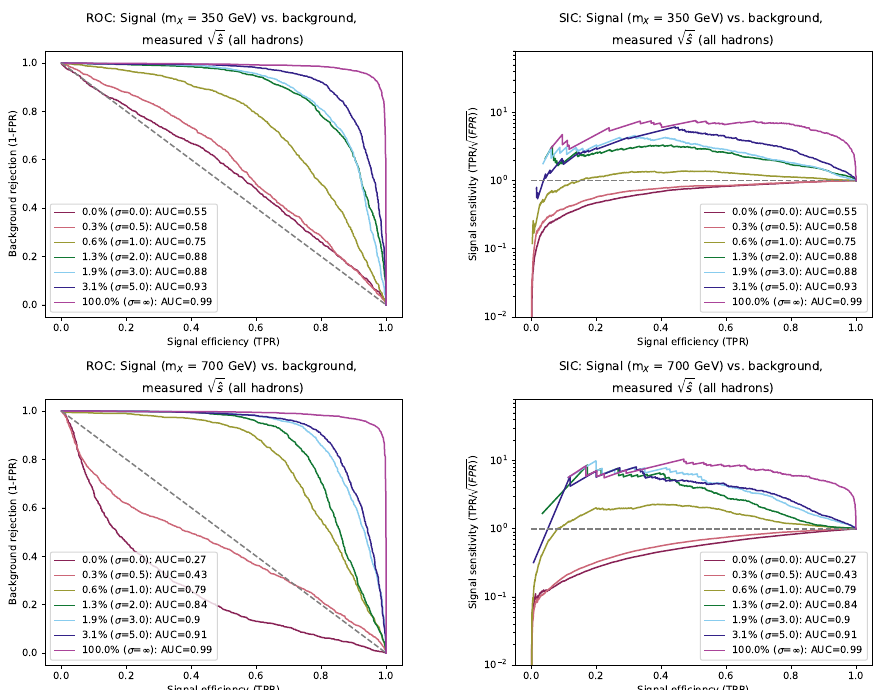
√ ˆ s , in the form of = 350 GeV (top) and m = 700 GeV (bottom) vs. X X